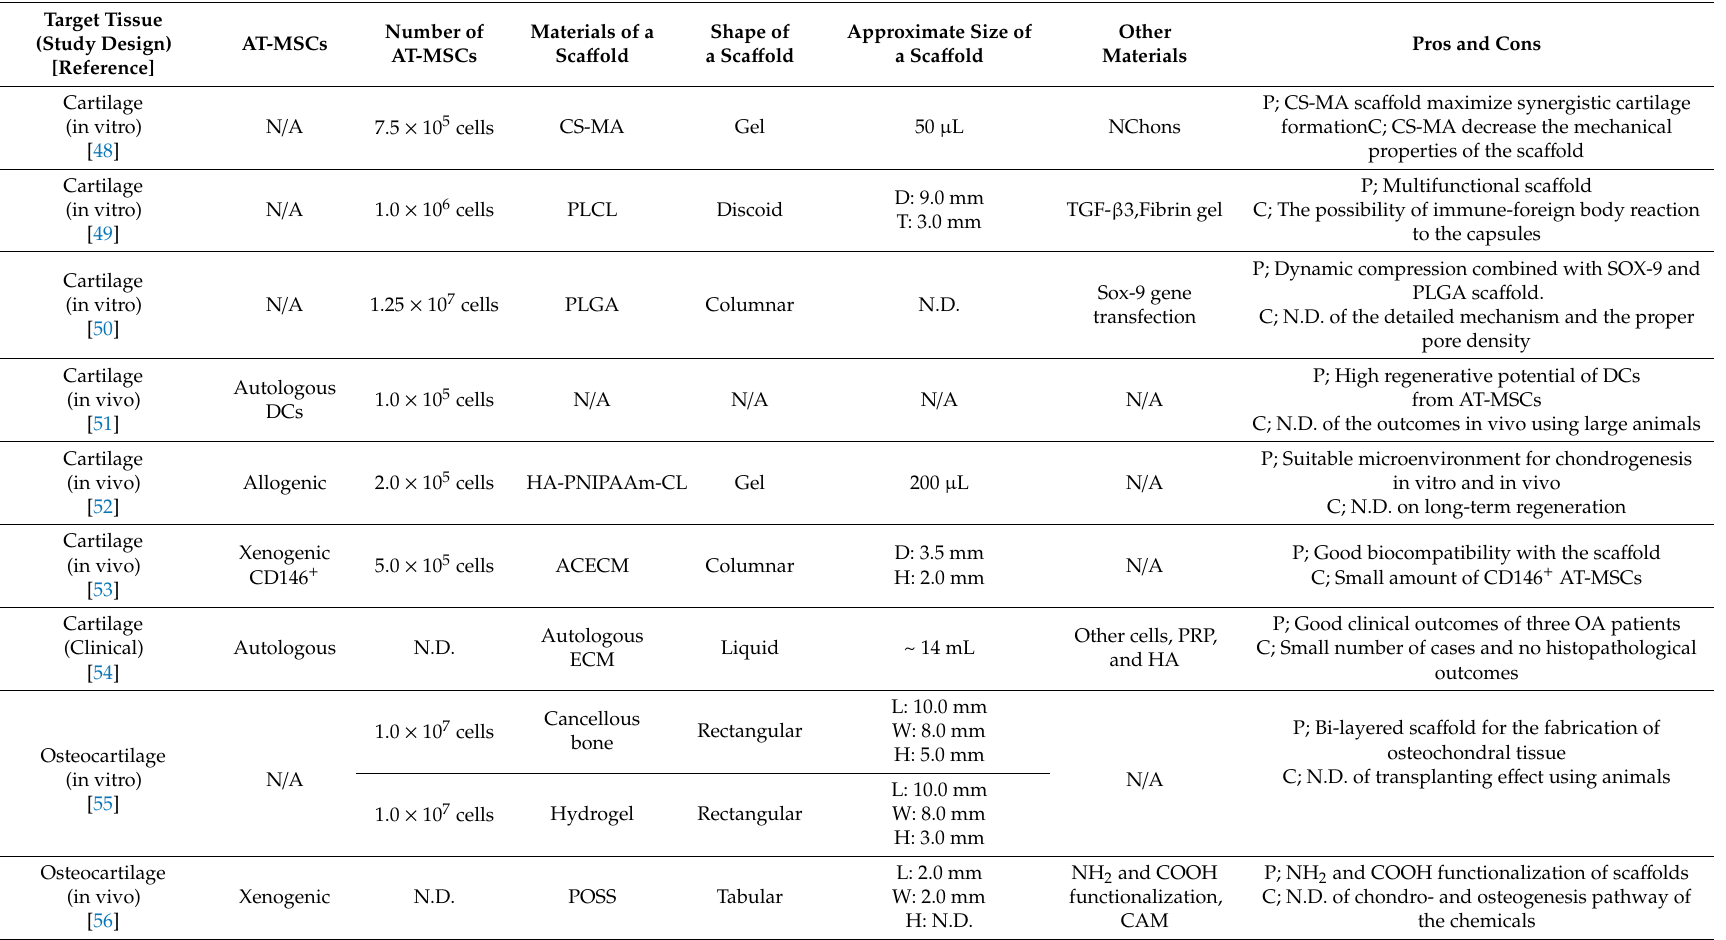
Table 1. Cartilage and osteocartilage regeneration using